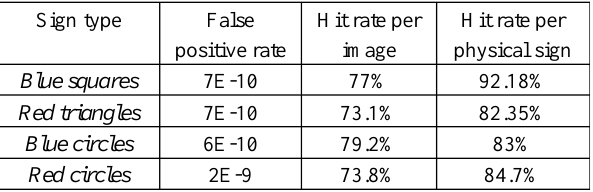
Table 1: Final accuracy of the detection cascade.